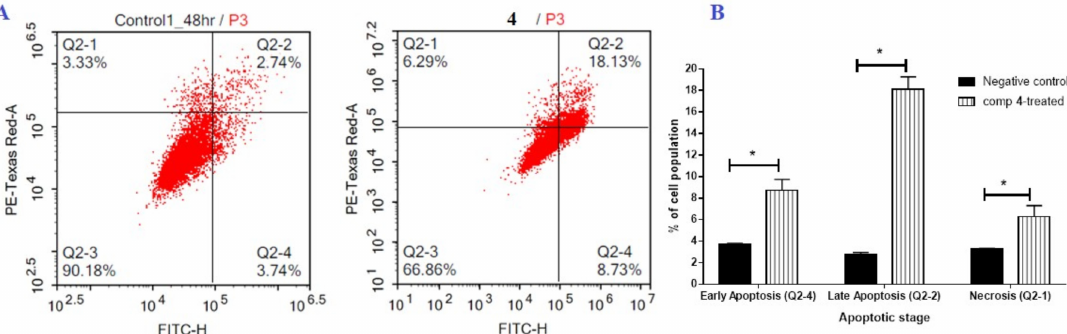
Figure 2. Induction of apoptosis in MCF-7 cells by compound 4 (23.2 µ M, 48 h). Cytograms